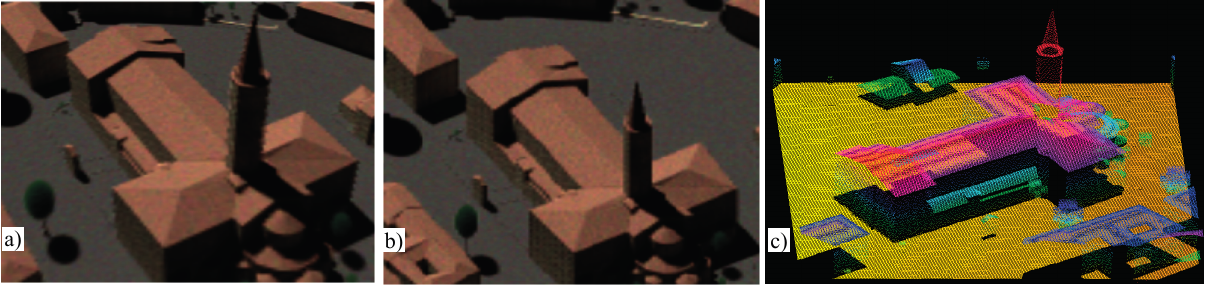
Figure 15. DART simulated products of the St. Sernin Basilica (Toulouse, France). ( a ) Airborne camera image (RGB color composite in natural colors) with the projective projection. ( b ) Satellite image with the orthographic projection. ( c ) Airborne LIDAR scanner simulation, displayed with SPDlib software.